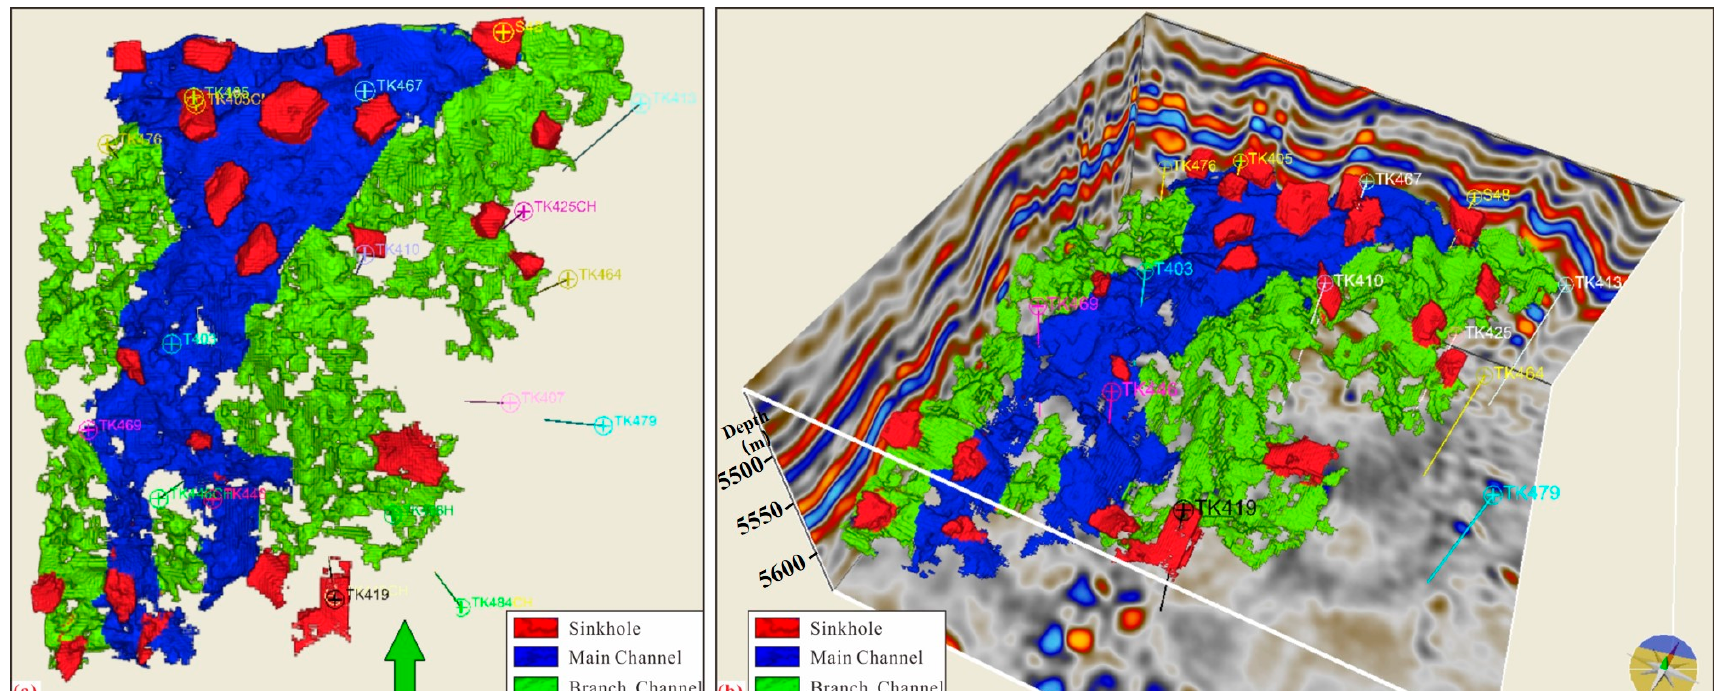
Figure 9. Three ‐ dimensional visualization of the well T403 area genetic paleocaves in the runoff zone. ( a ) Top view of the 3D modeling result, ( b ) a depth scale view of the Figure 9. Three-dimensional visualization of the well T403 area genetic paleocaves in the runo ff zone. ( a ) Top view of the 3D modeling result, ( b ) a depth scale view of 3D modeling result. the 3D modeling